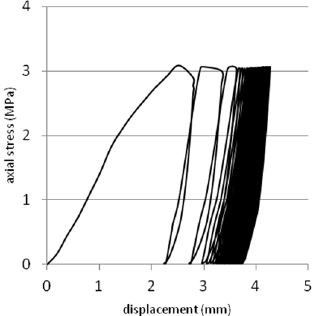
Figure 11. Plot of cCBR test results for steel slag after 50 cycles of loading (soaked conditions).